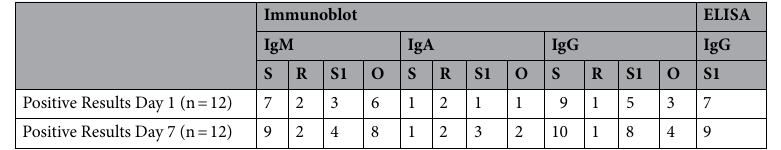
Table 3. Comparison of the results from the immunoblot and ELISA analysis. Positive results for each category were counted. n = 12.